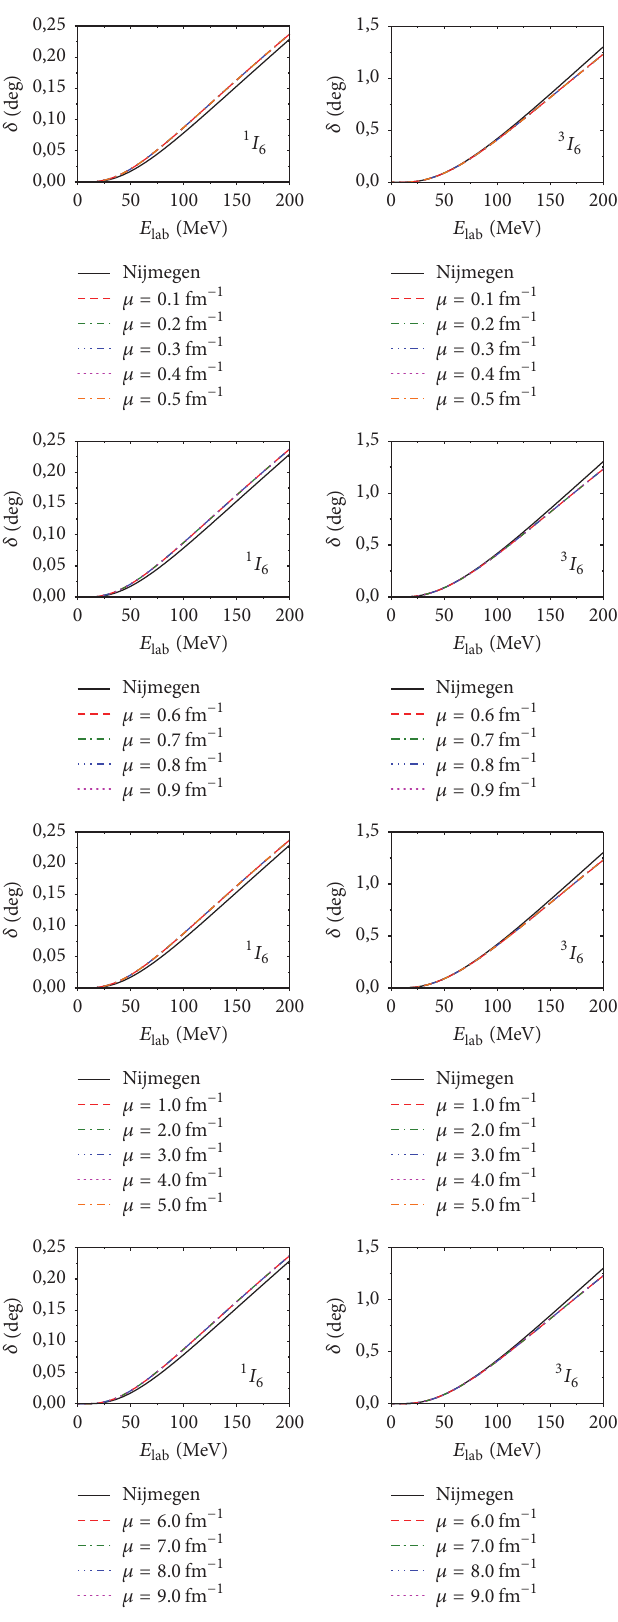
Figure 4: (Color on-line) phase shifts in 1 𝐼 6 and 3 𝐼 6 uncoupled channels calculated from the solution of the subtracted LS equation for the 𝐾 -matrix with five subtractions for the N3LO-EM potential for several values of the renormalization scale compared to the Nijmegen partial wave